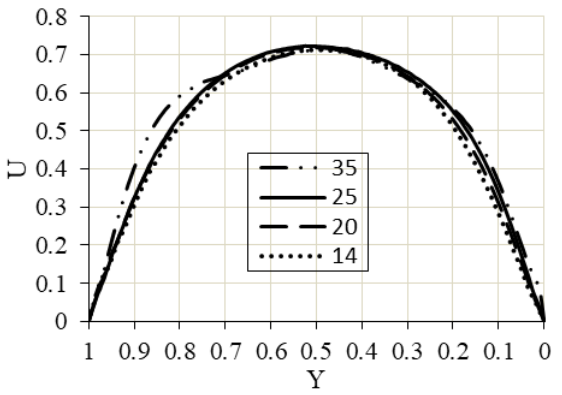
Fig. 6. Air velocity at midlength (X=0.5L) of different